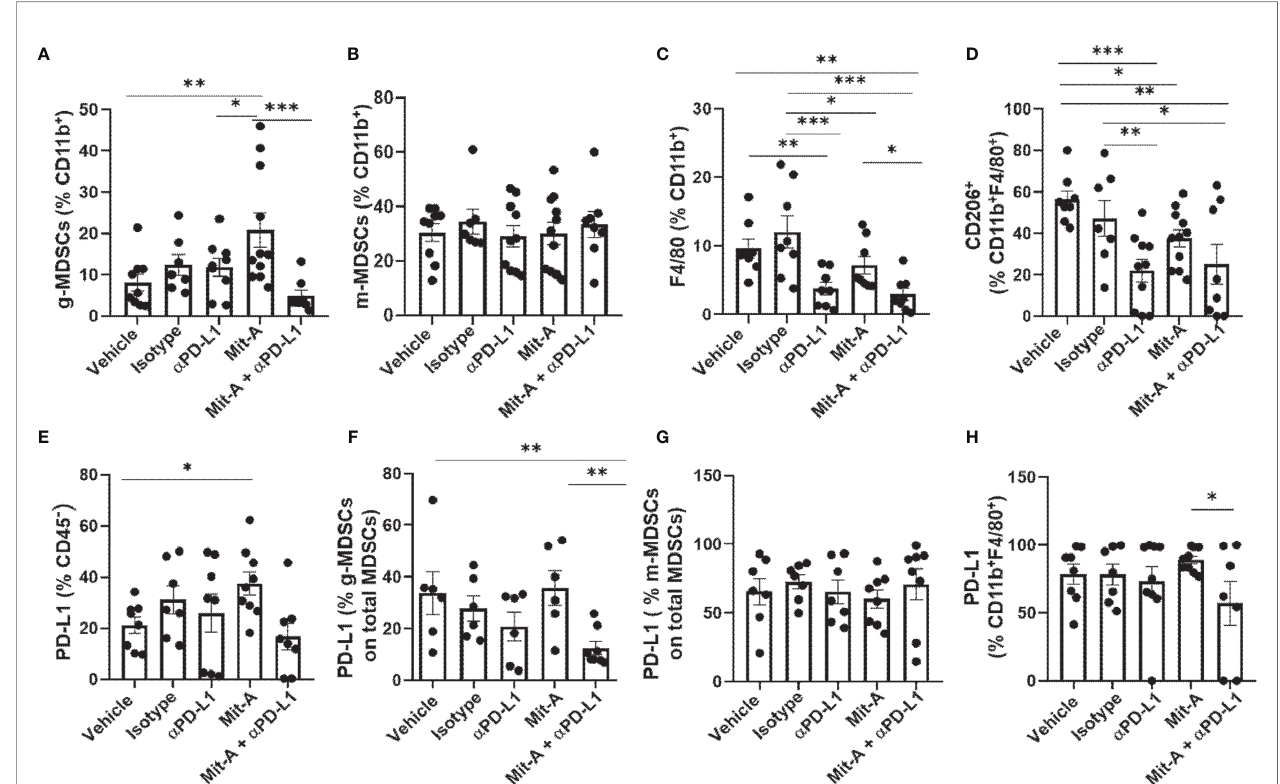
FIGURE 5 | Mit-A and anti-PD-L1 combination treatment decreases the immunosuppressive g-MDSCs population. Mit-A sensitizes orthotopic tumor and immune cells by modulating PD-L1 expression in vivo . Flow cytometry analyses of tumor from the MC38 orthotopic tumor bearing mice from the fi ve groups treated with vehicle, IgG (isotype), a PD-L1 mAb, Mit-A and Mit-A + a PD-L1 mAb where all cell populations were gated out of CD45 + live cells. (A) Percentage of g-MDSCs (CD11b + Ly6G + Ly6C low (granulocytic)) and (B) m-MDSCs ((CD11b + LyG - Ly6C + (monocytic) populations from tumor of MC38 orthotopic-tumor bearing mice shown. (C, D) Percentage of CD11b + F4/80 + macrophage and CD206 + CD11b + F4/80 + anti-in fl ammatory M2-macrophage populations, respectively from tumor treated with the fi ve treatment groups shown. (E – H) Percentages of PD-L1 expression on CD45 - tumor cells (E) , g-MDSCs (F) , m-MDSCs (G) from tumor (calculated out of total MDSCs) and tumor CD11b + F4/80 + macrophage population (H) . Each dot represents one mouse in every group. Data pooled of two experiments (minimum of n = 3 per group for each experiment) and analyzed as mean ± SEM by One way ANOVA (Fischer ’ s LSD test). *p < 0.05, **p < 0.01, ***p <